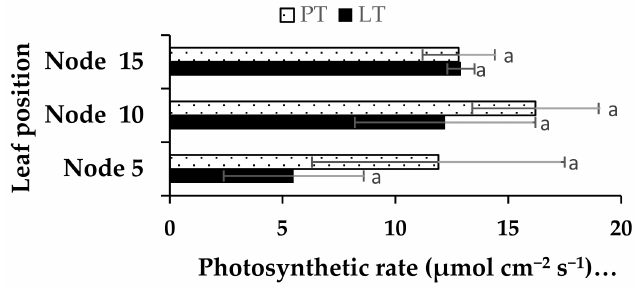
Figure 8. Effect of training methods on photosynthetic rate of individual leaf. Within each node, the same letters are not significantly different at p < 0.05 by the Tukey’s multiple comparison test.